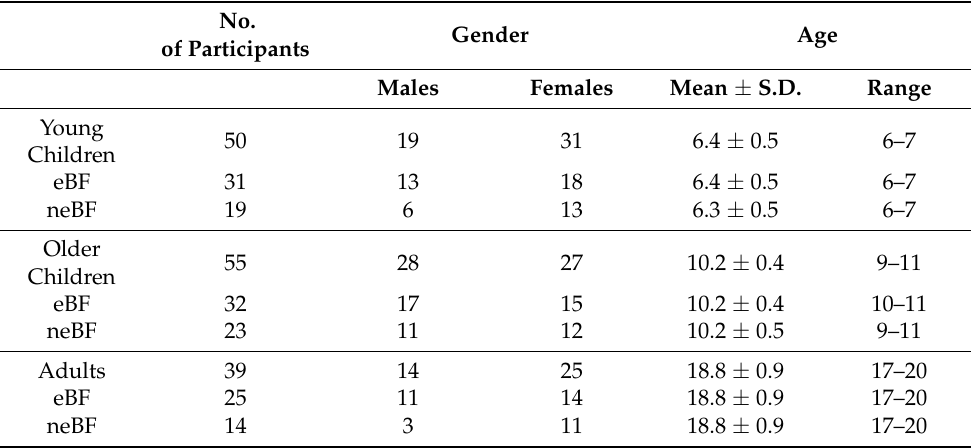
Table 1. Participants’ demographic characteristics for each age